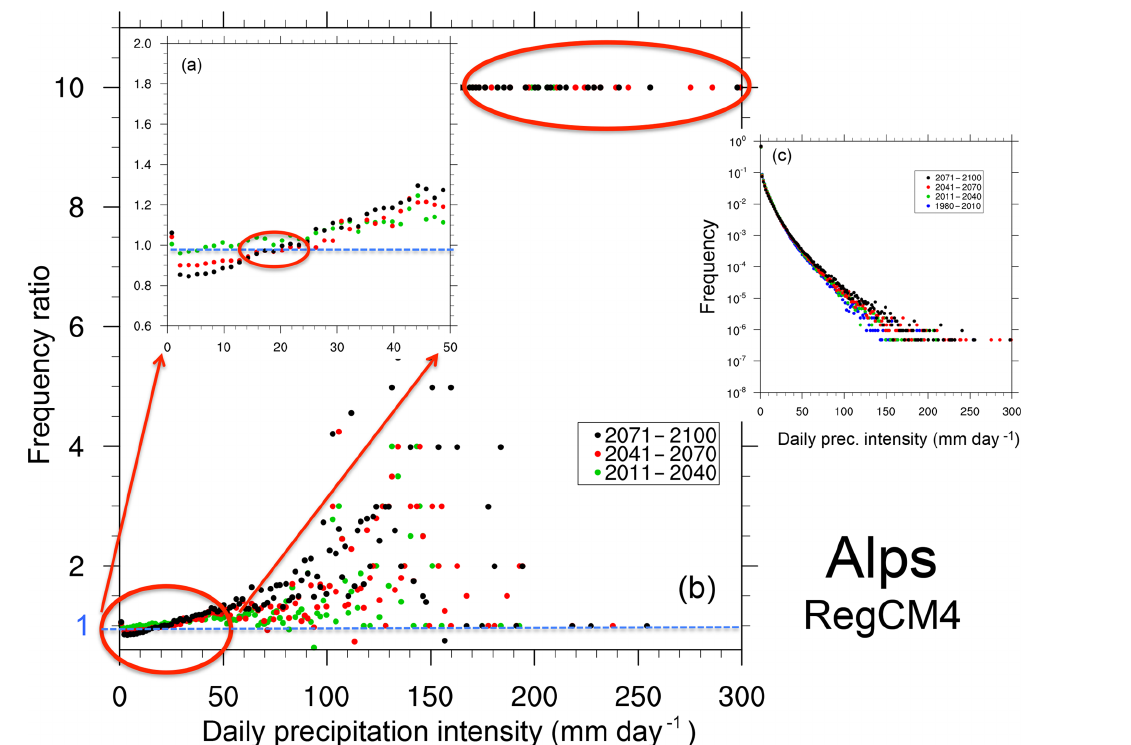
Figure 6. Same as Fig. 5 but for the Alpine